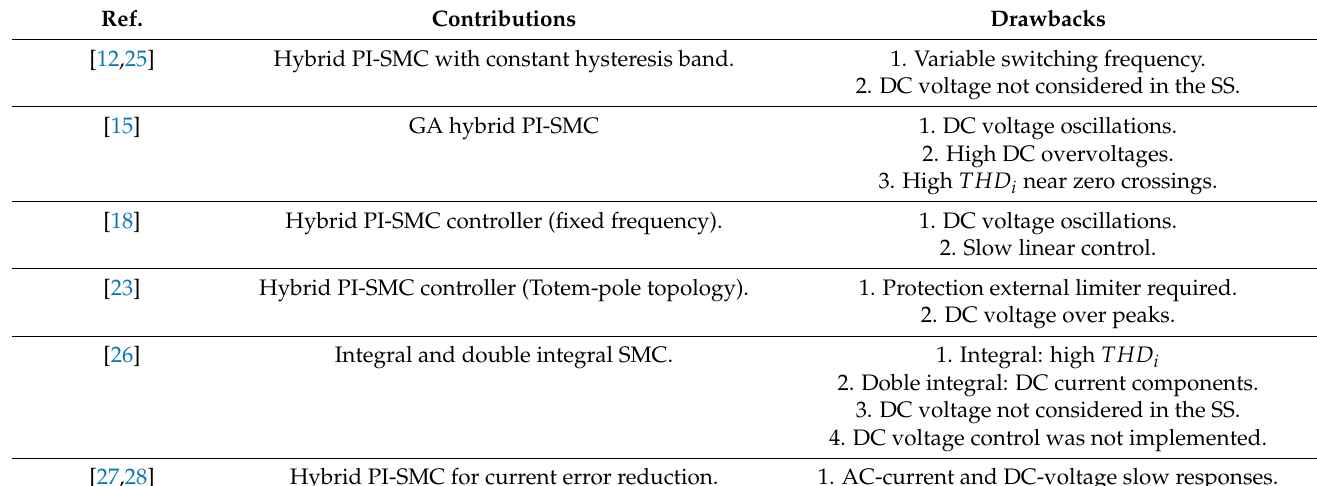
Table 1. Key points of the literature review. Ref. Contributions